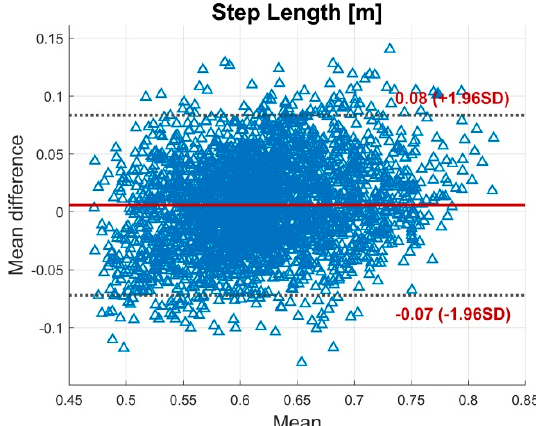
Figure A6. BA plot for the step length. The plot contains all calculated data points of all subjects. The solid line indicates the mean difference. The dashed lines indicate the LoA (95% CI of the mean difference).